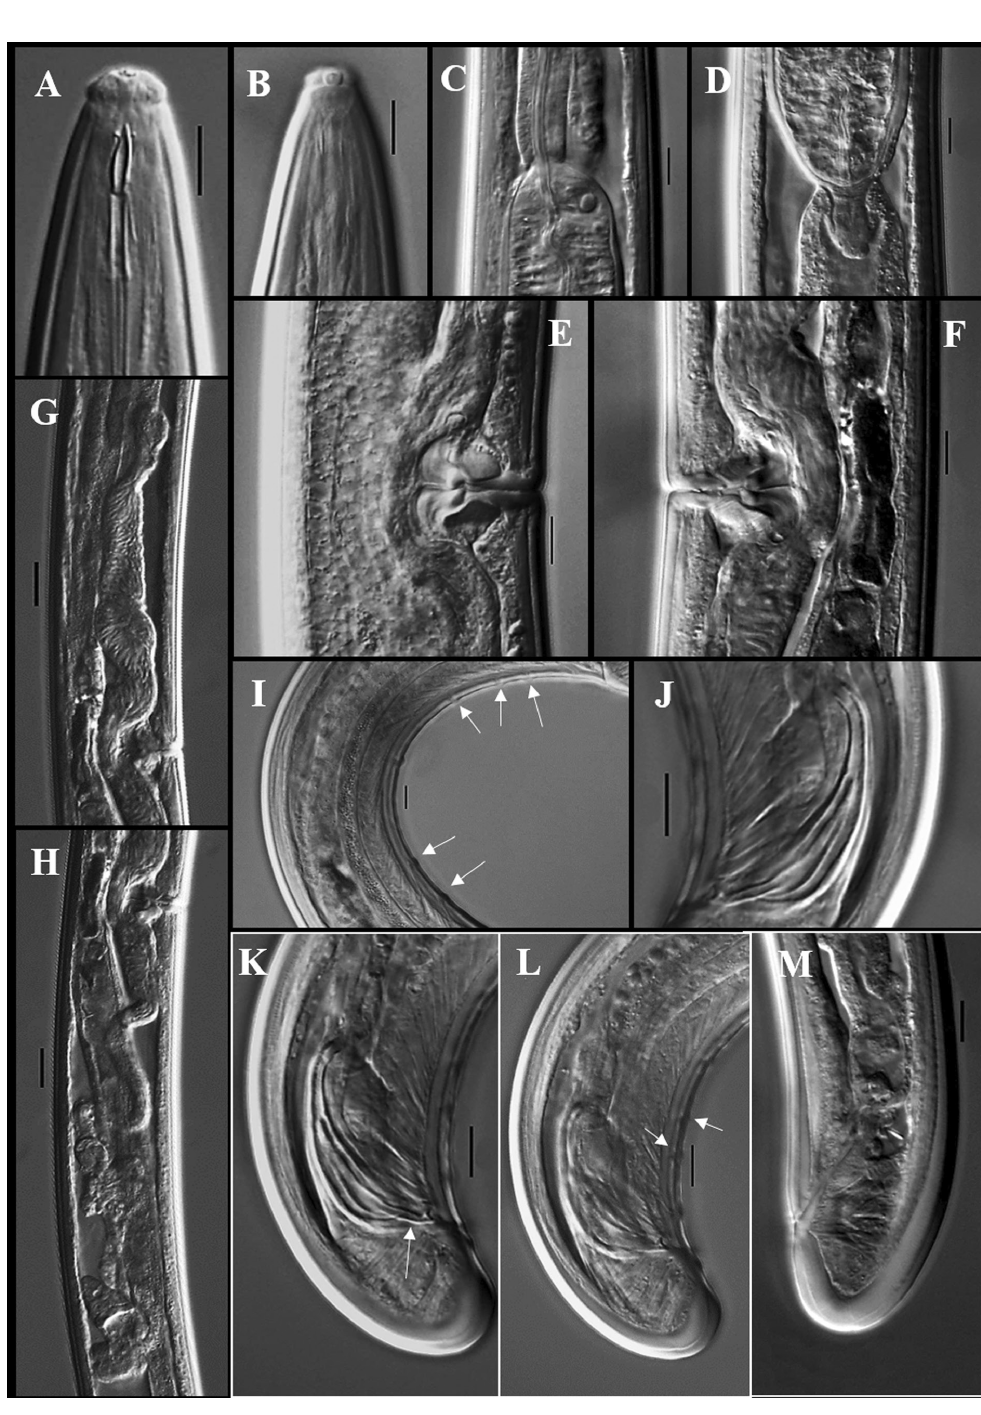
Fig. 2. Axonchium saccatum Jairajpuri, 1964 (LM photographs). A . Anterior region. B . Anterior region showing amphid. C . Junction between two parts of the pharynx. D . Cardia. E – F . Vulva and vagina. G – H . Female genital branches. I . Ventromedian supplements. J . Spicule. K . Male posterior region, arrow indicating lateral guiding piece. L . Arrow indicating beginning of ventromedian supplements. M . Female posterior end. Scale bars: A–F, I–M = 10 µm; G–H = 20